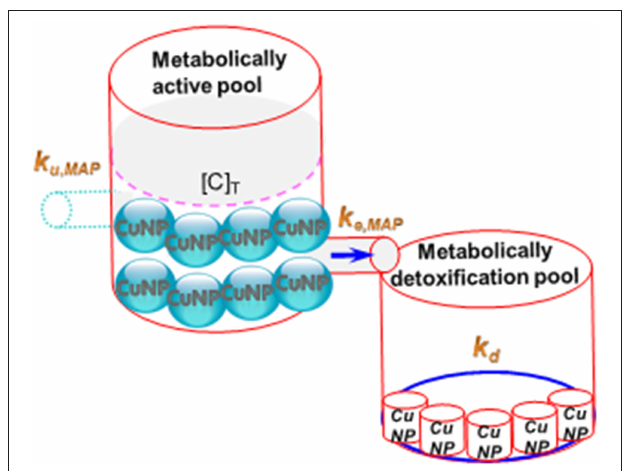
FIGURE 1 | Scheme showing the CuNPs accumulative pattern between MAP and MDP.